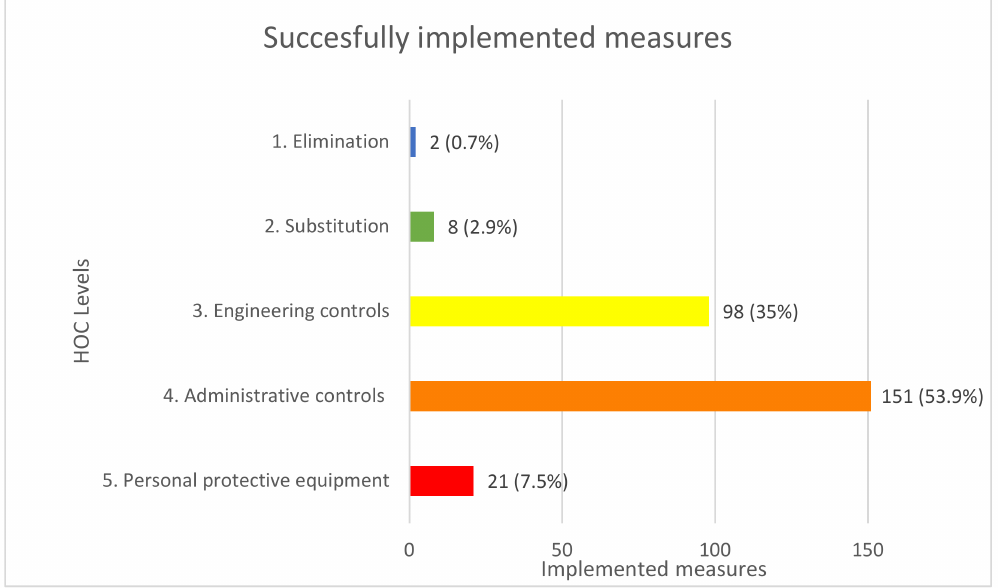
Figure 2. Number of implemented measures and percentage of HOC